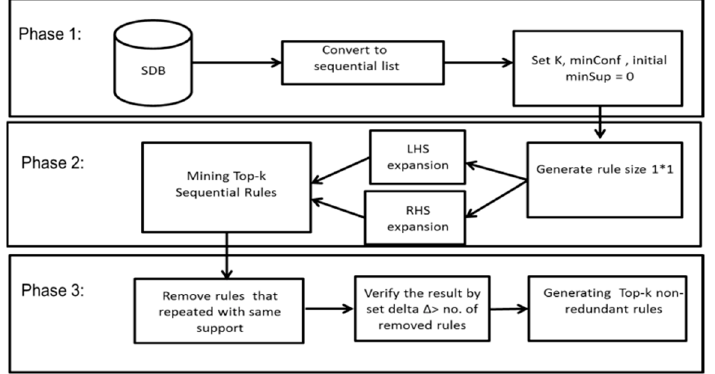
Figure 2. framework of TNS